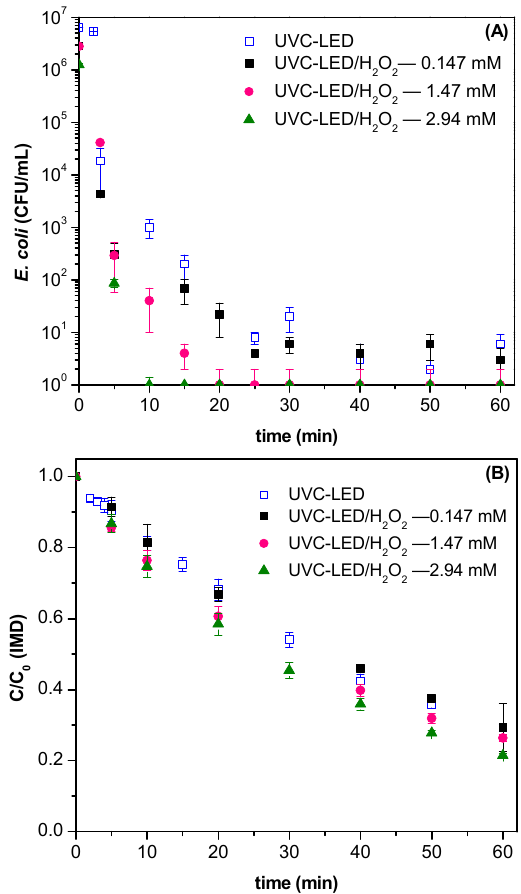
Figure 3. Effect of the initial concentration of H 2 O 2 (0.147, 1.47, and 2.94 mM) on simultaneous E. coli inactivation ( A ) and IMD removal ( B ) by UVC-LED/H 2 O 2 process.